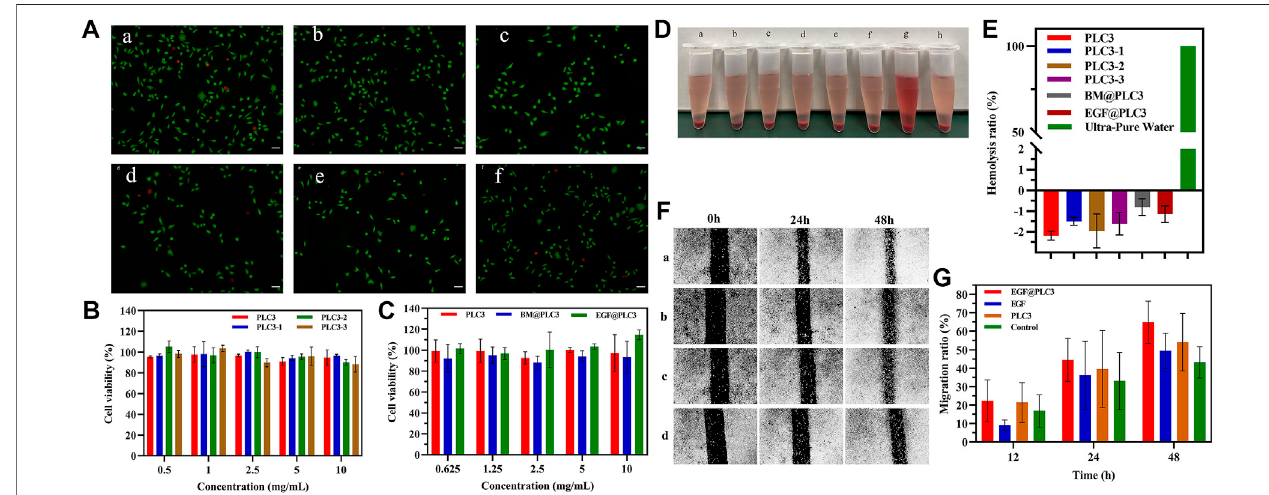
FIGURE5| Invitro biocompatibilityandcell-proliferationtests. (A) Live/Deadstainingofa)EGF@PLC3,b)BM@PLC3,c)PLC3,d)EGF,e)BM,andf)control;scale bar: 100 μ m. (B) CCK-8 for blank hydrogels. (C) CCK-8 for hydrogels loaded with drugs. (D) Hemolysis test on a) PLC3, b) PLC3-1, c) PLC3-2, d) PLC3-3, e) BM@ PLC3,f)EGF@PLC3,g)Ultra-purewater,andh)saline. (E) Thequantitativeresultofhemolysistest. (F) Cellscratchtestona)EGF@PLC3,b)EGF,c)PLC3,andd)control groups. (G) Measuring analysis on cell scratch test. With the data shown as means ± SD ( n (cid:1) 3).